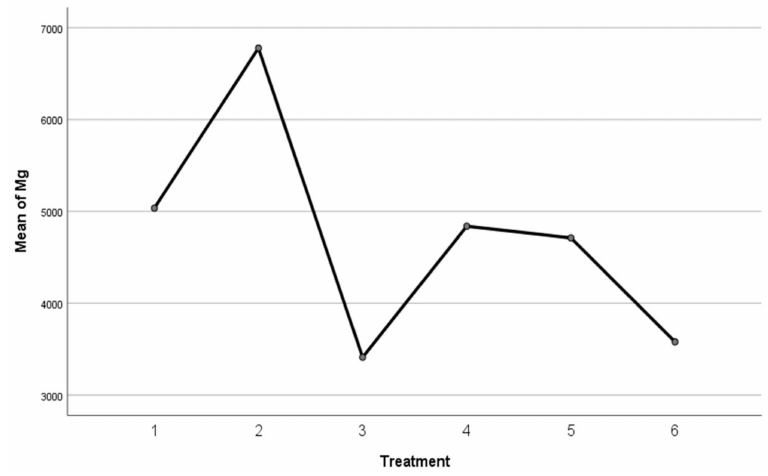
Figure 3. Average comparison of Mg. Note: unit of measure is mg × kg − 1